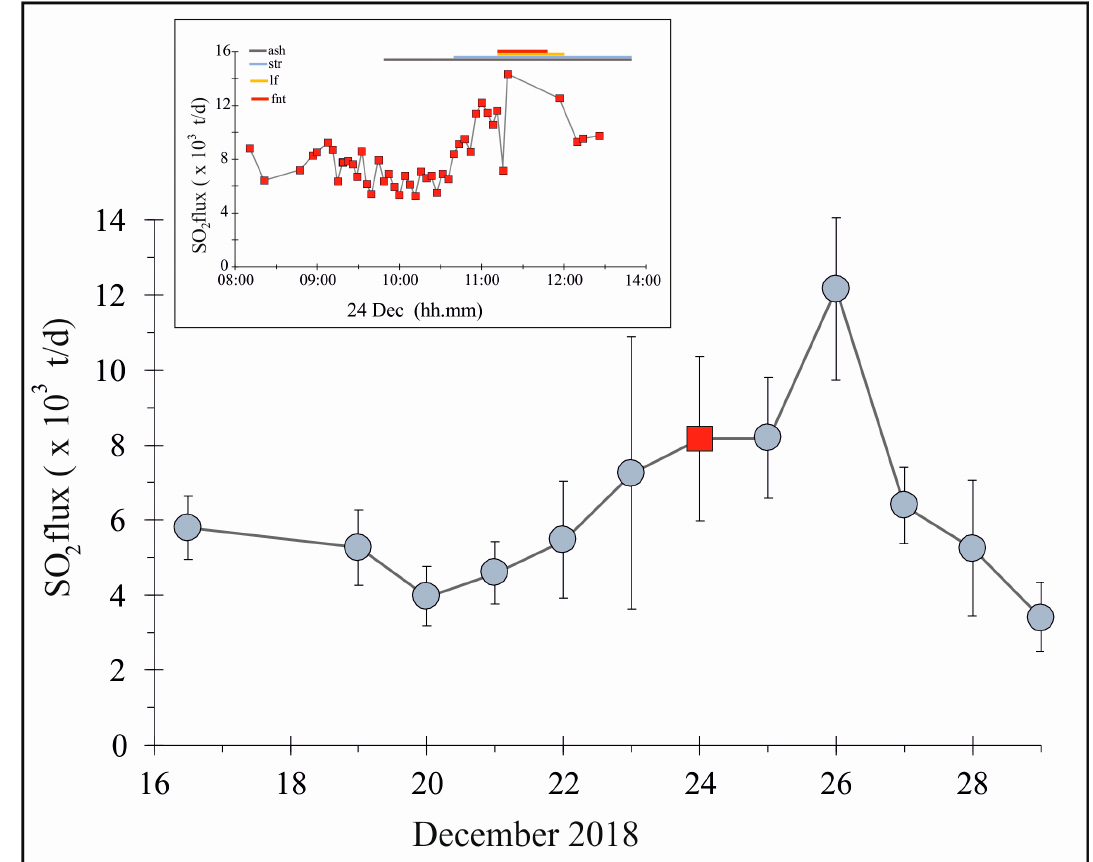
Figure 10. Daily plume bulk SO 2 flux measured by the FLAME network between 16 and 29 December, 2018. The vertical bar shows the infra-day variability of the flux, and the red square is the daily flux recorded on 24 December. In the upper-left of the graph is displayed the infra-day SO 2 flux measured on 24 December, together with the eruptive activity taking place over the day (details are in Table 2). The colored lines indicate the eruptive activity: ash emission (grey), Strombolian explosions (pale blue), lava flows (yellow), and lava fountains (red). Uncertainty in emission rates range between − 22 and +36%.